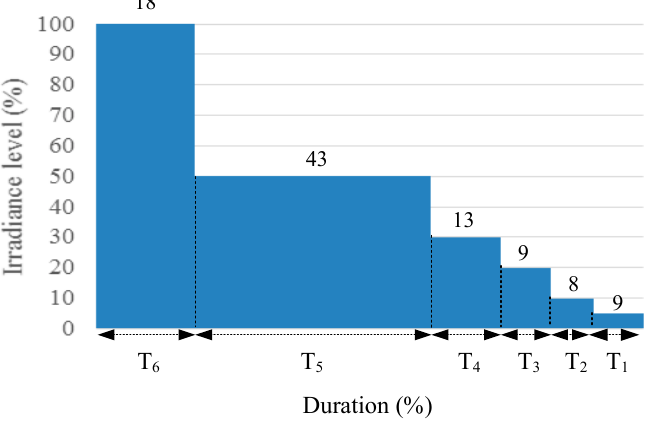
Figure 9. The irradiance-duration curve produced by the SB3000HF inverter. Table 5. Weighted efficiency for the SB3000HF inverter when G = Gi and T = 25 °C with individual weightage.